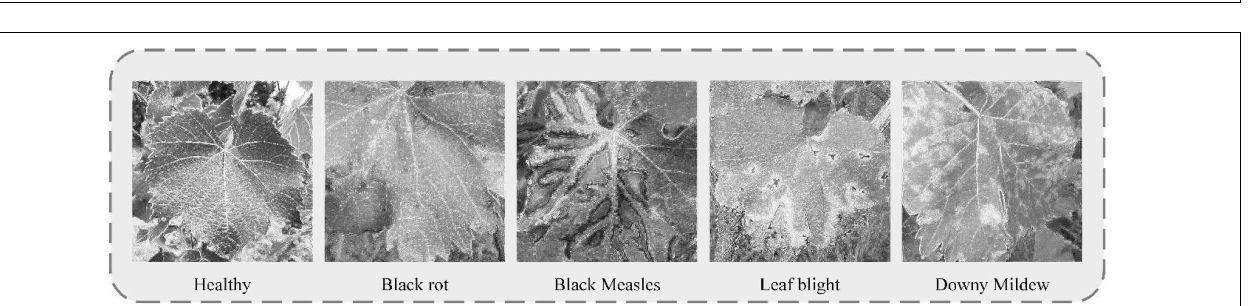
FIGURE 2 | Eight transformation images of downy mildew as an